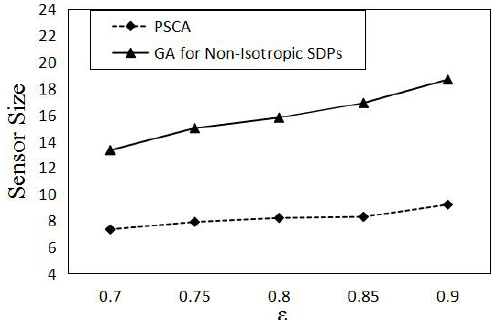
Figure 11. Sensor size vs. (cid:101) . Forty sensors are uniformly deployed in a 50 m × 50 m area. The number of targets is 10, and we set p min =